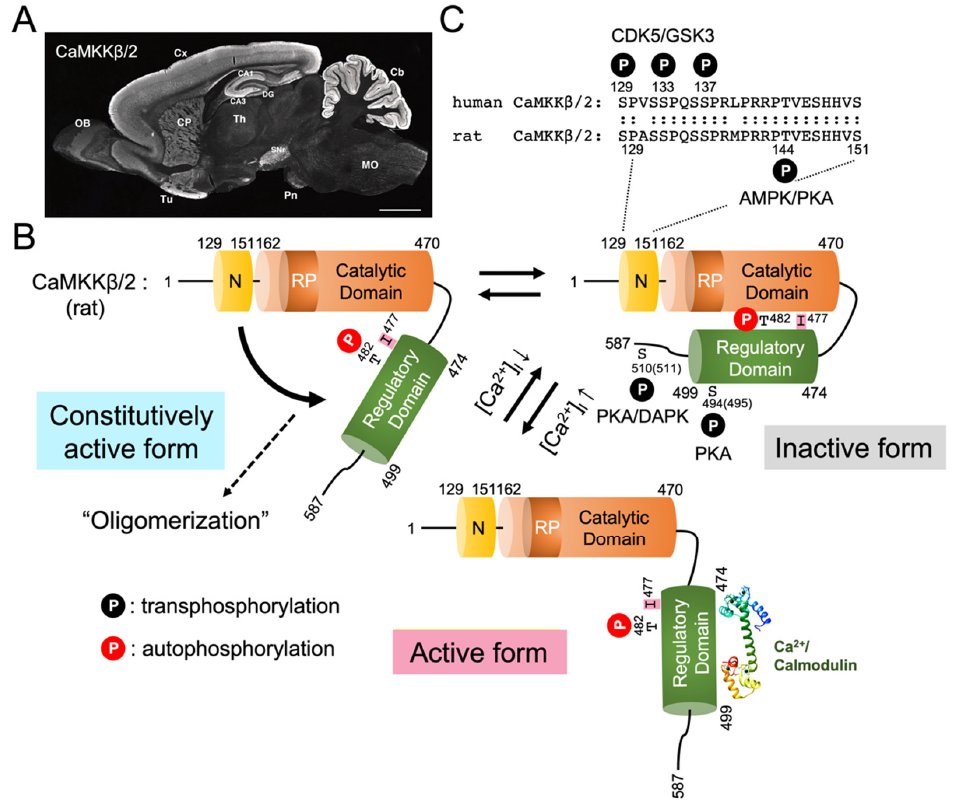
Figure 2. CaMKK β /2 activation mechanism and immunohistochemical localization in the rat brain. ( A ) Sagittal section of the adult rat brain immunostained with a monoclonal antibody against CaMKK β /2 (reproduced from Ref. [61], with permission from John Wiley and Sons). CA1 and CA3, CA1 and CA3 subregions of Ammon’s horn of the hippocampus; Cb, cerebellar cortex; CP, caudate putamen; Cx, cerebral cortex; DG, dentate gyrus;